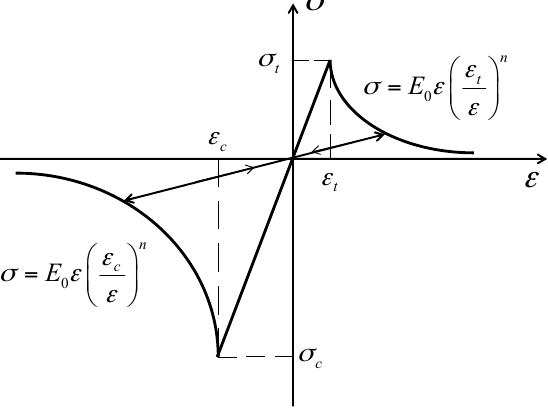
Figure 1. Typical constitutive law for rock under uniaxial stress.